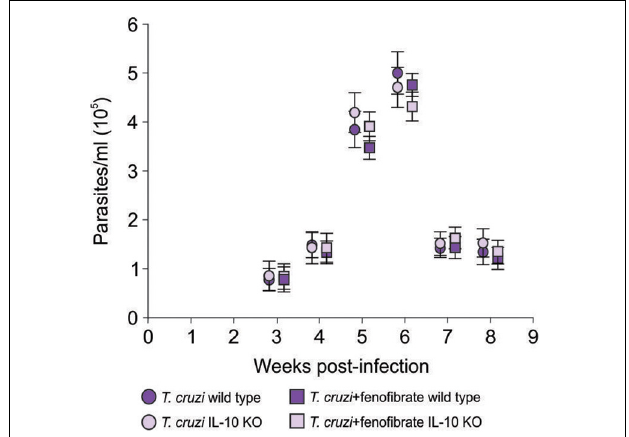
FIGURE 1 | Parasitemia. Bloodstream parasites were quantified between 3- and 8-weeks pi, by the method of Pizzi modified by Brener, in infected and fenofibrate-treated IL-10 KO and WT. N = 7 mice per group. 3 replicate experiments. Point to point Student t test, mean ± SEM, p =